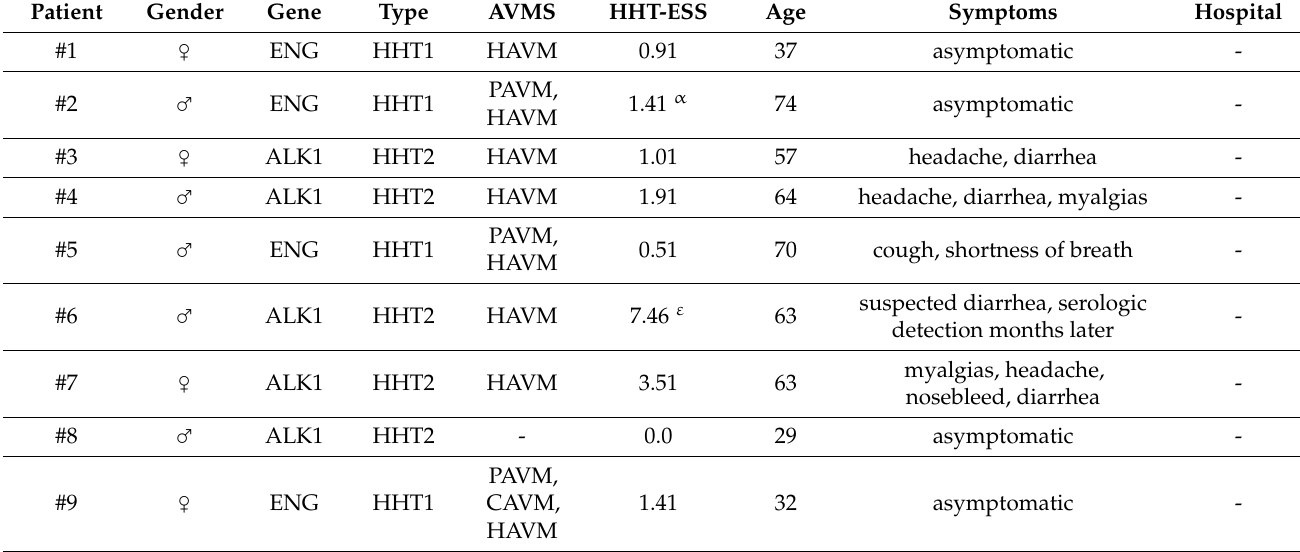
Table 1. HHT characteristics and COVID-19 symptoms in the affected group. Results related to HHT symptoms in the positive COVID-19 cases, and the COVID-19 infection derived